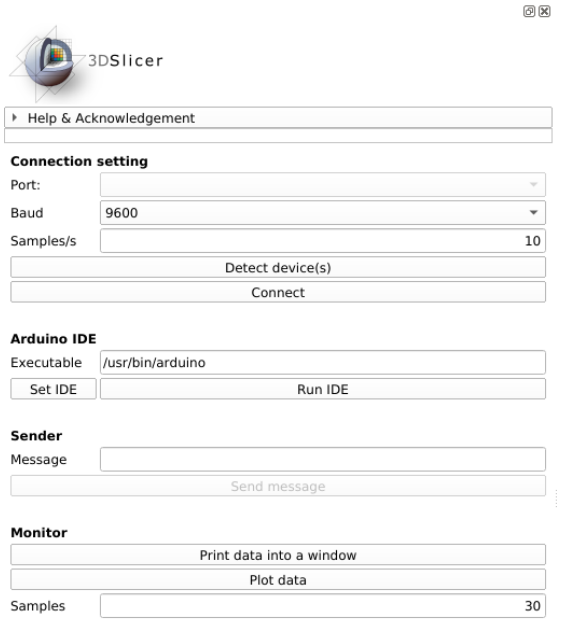
Figure 1. SlicerArduino Graphical User Interface (GUI).